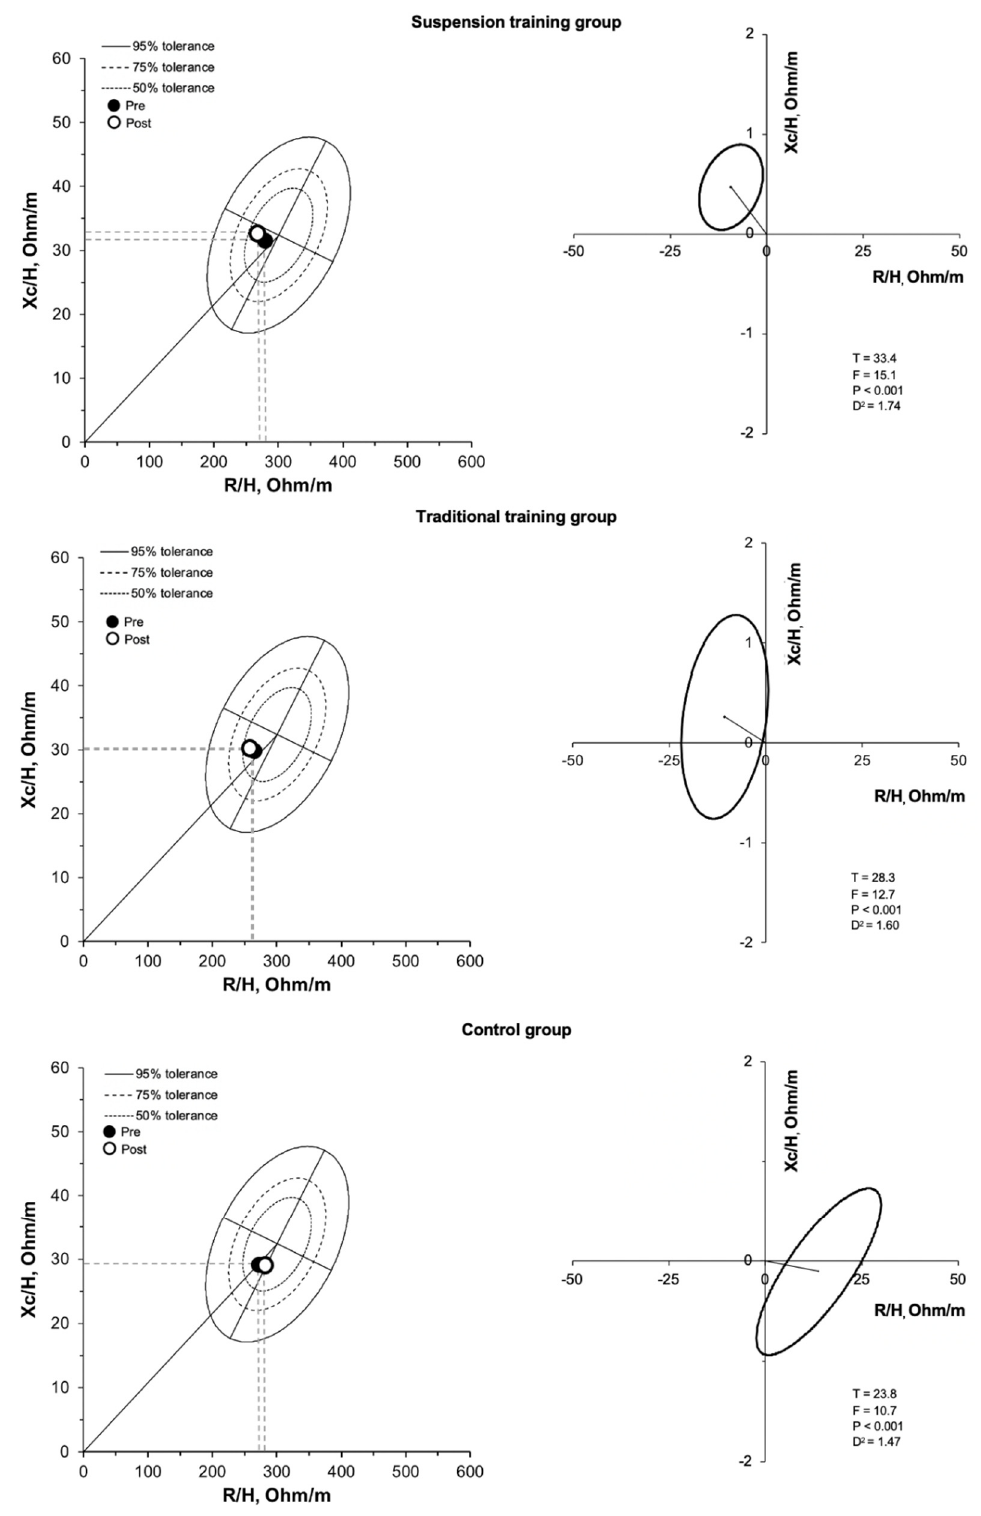
Figure 3. R-Xc and paired graphs for the multivariate changes in classic resistance and reactance are shown. On the left panels, bioimpedance data are plotted on the tolerance ellipses of the reference population. On the right panels, mean vector displacements with 95% confidence ellipses and results of the Hotelling’s T 2 test are shown.